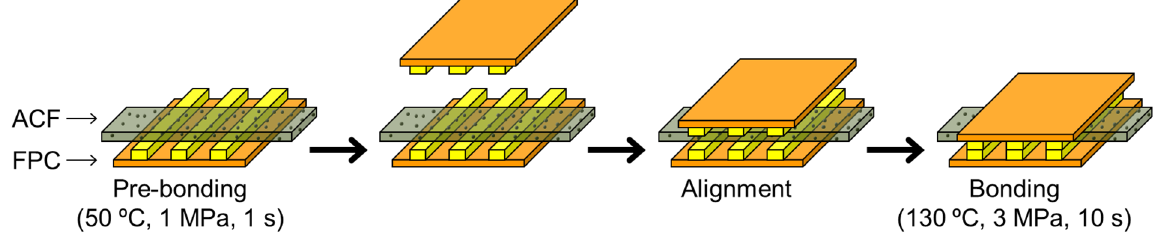
Figure 7. Connection process using